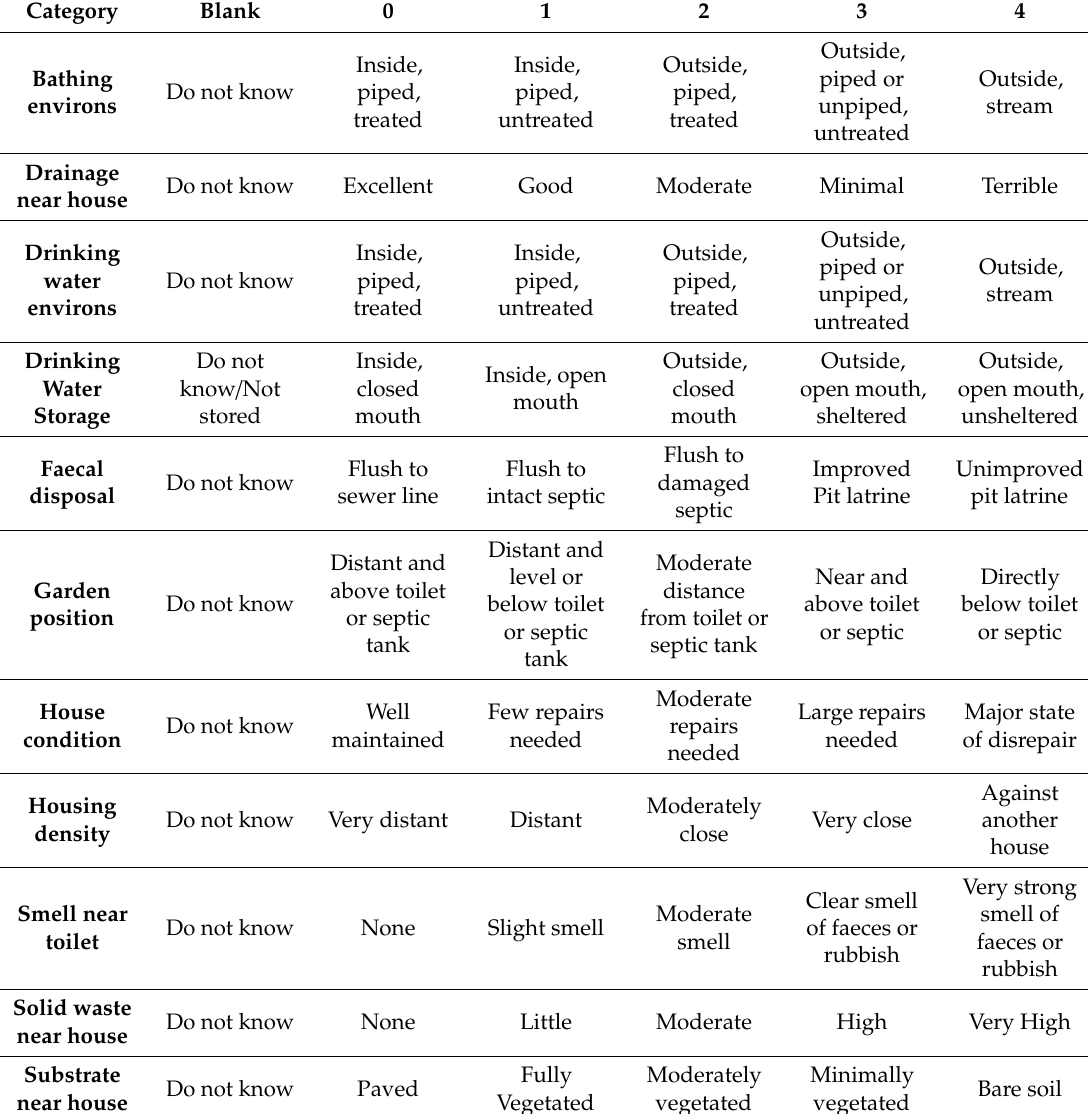
Table A1. Rubric for evaluation of living conditions, Fiji typhoid case-control study, 2014–2015